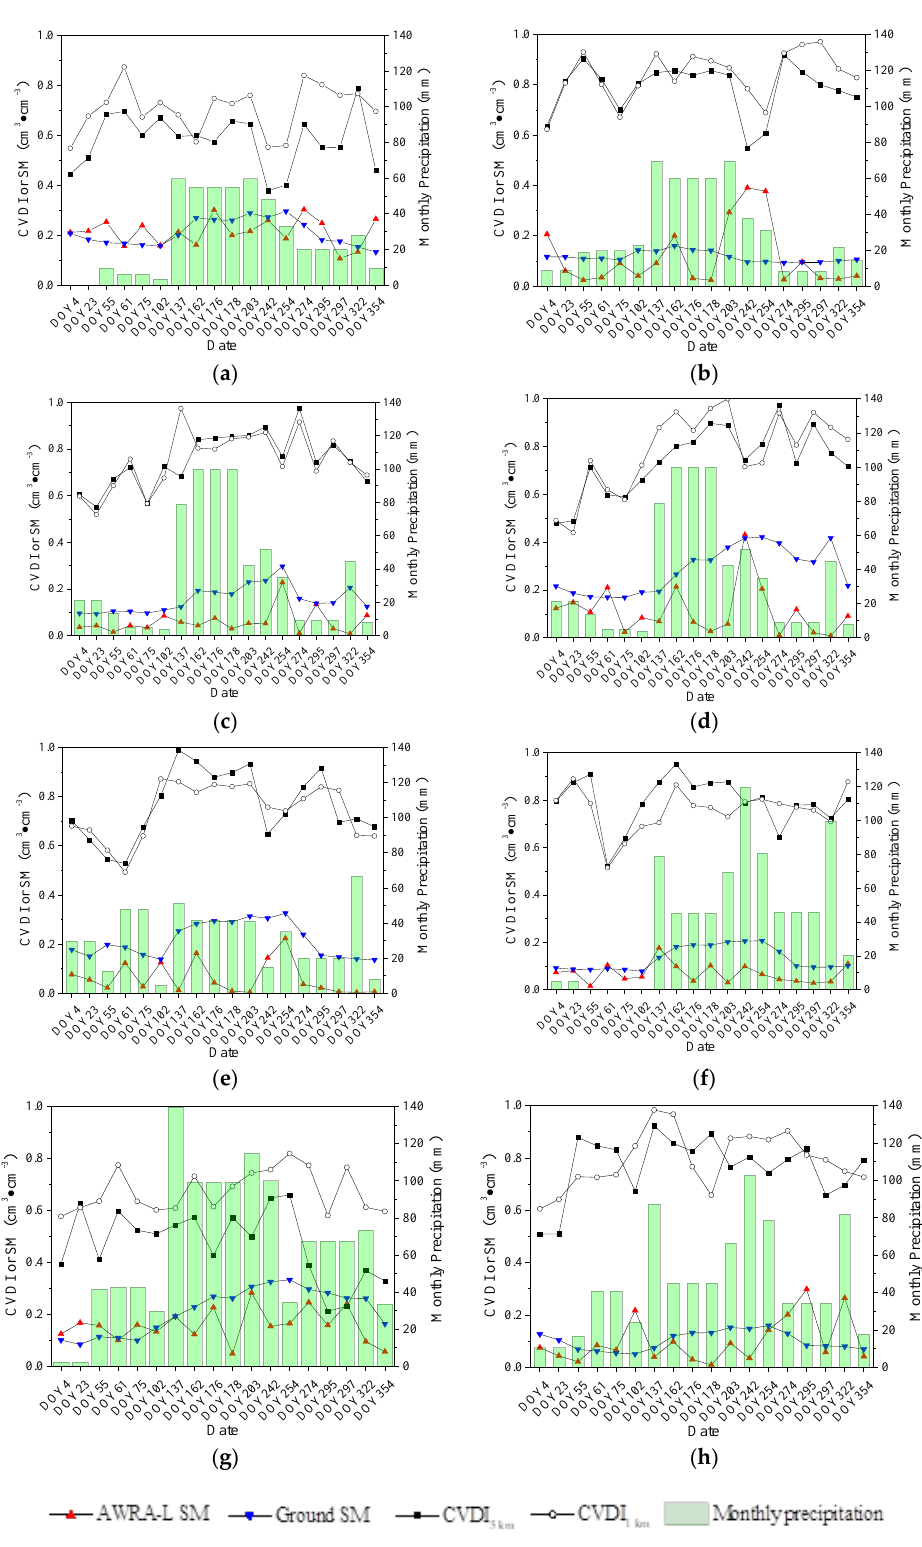
Figure 8. Time series of the AWRA-L SM data, ground measurements, and the CVDI at 1 and 5 km resolutions with the monthly cumulative precipitation for 8 sites including ( a ) Lawloit, ( b ) Greta, ( c ) Baynton Basalt, ( d ) Baynton granite, ( e ) Bairnsdale, ( f ) Longwarry, ( g ) Jancourt and ( h )